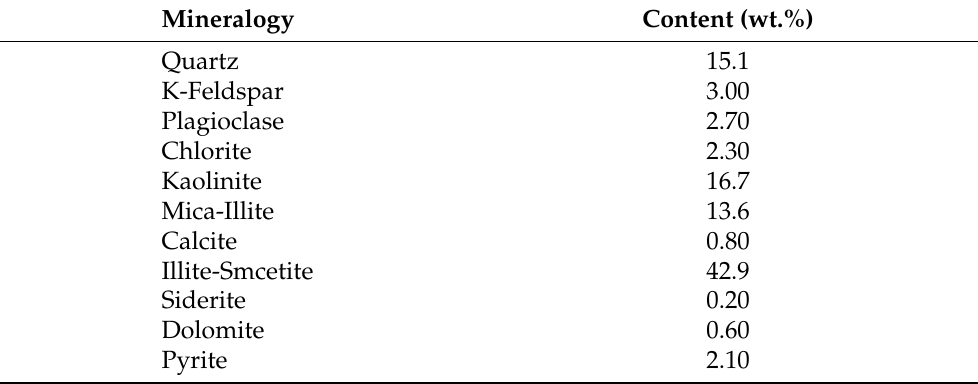
Table 1. Mineralogical composition of Draupne Shale from X-ray diffraction (XRD) analysis.